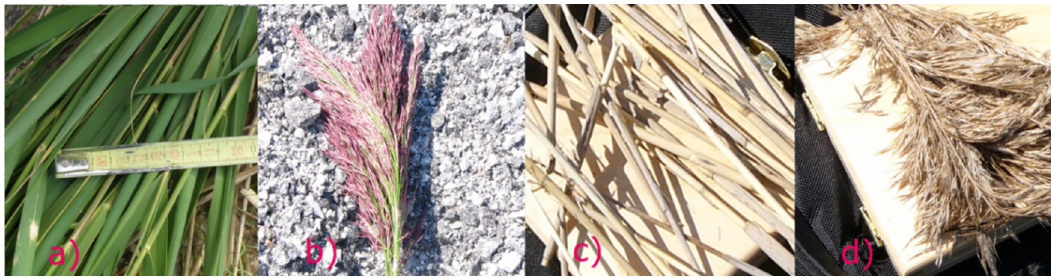
Figure 8. Samples of measured reed components: ( a ) live leafs; ( b ) live inflorescence; ( c ) dead stems; and ( d ) dead inflorescence.